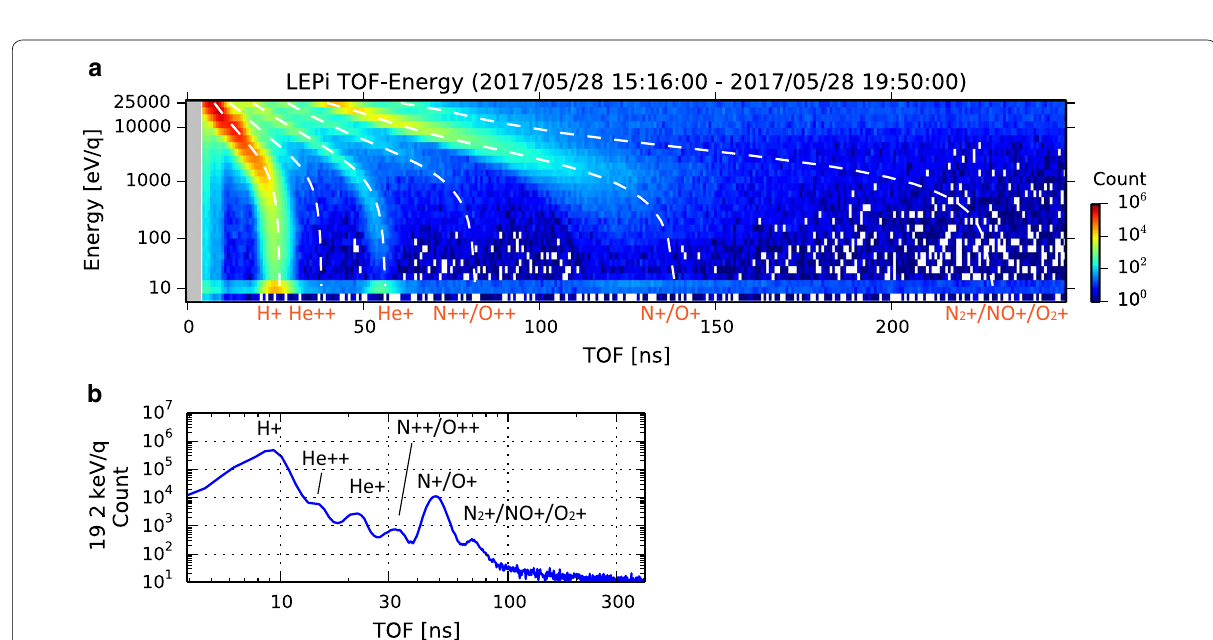
Fig. 17 a Energy (E/q)-TOF diagram observed at 1516–1950UT on May 28, 2017. The data are summed within the period. White dashed lines indicate the average TOF values obtained in laboratory experiments for H + , H + 2 / He ++ , He + , N ++ , N + , and N + 2 . b TOF spectrum with the energy of 19.2